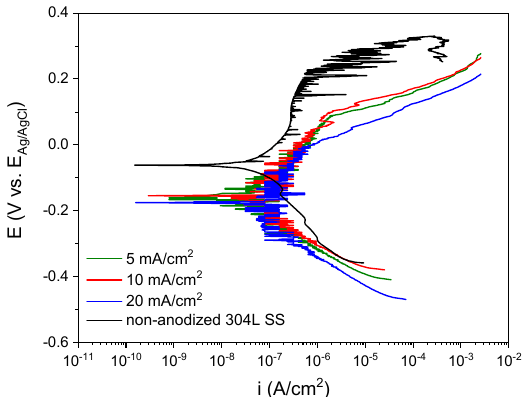
Figure 6. Potentiodynamic polarization curves for anodic layers grown in glycerol electrolyte con- taining 0.1 M Na 2 SiO 3 and 2.5 vol% H 2 O.